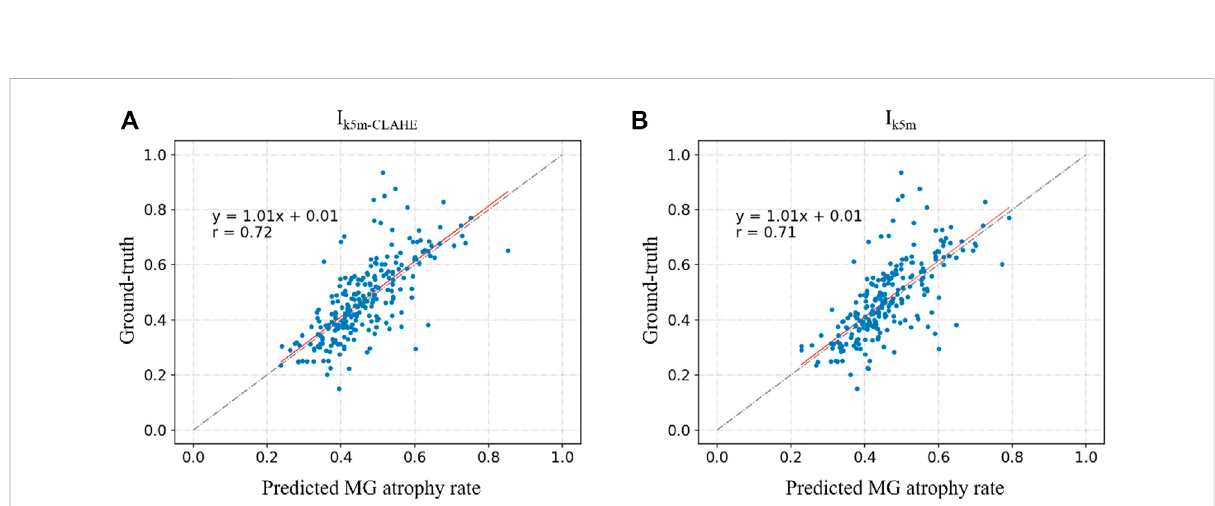
FIGURE 7 (A) and (B) represent the direct comparison of the ground real and predicted MG atrophy rates of the unprocessed image set Ik5m, image set I5m-CLAHE processed with CLAHE, respectively.